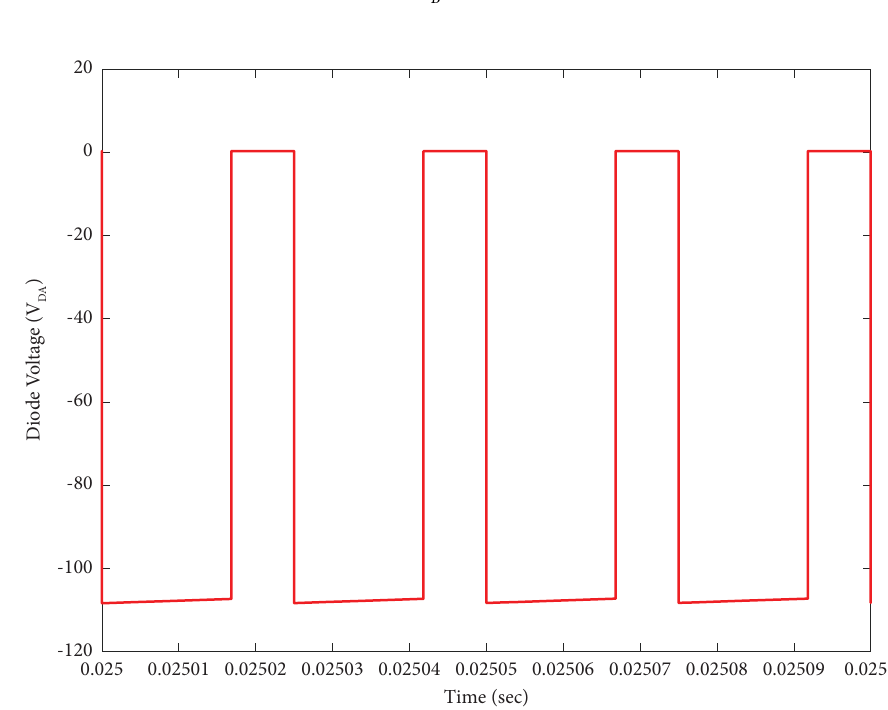
Figure 13: Te diode D A simulated voltage